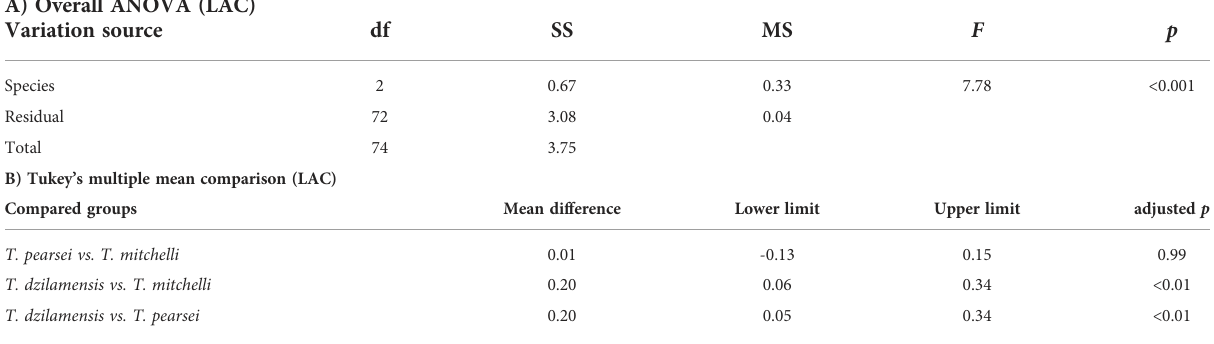
TABLE 2 Lactate content (LAC) in BL and post-exercise individuals of T. mitchelli , T. pearsei and T. dzilamensis .